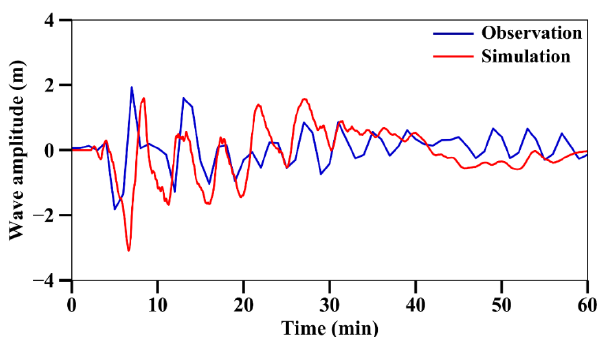
Figure 7. Comparison between observed and simulated wave heights at Pantoloan tidal gauge in Palu Bay, Sulawesi,